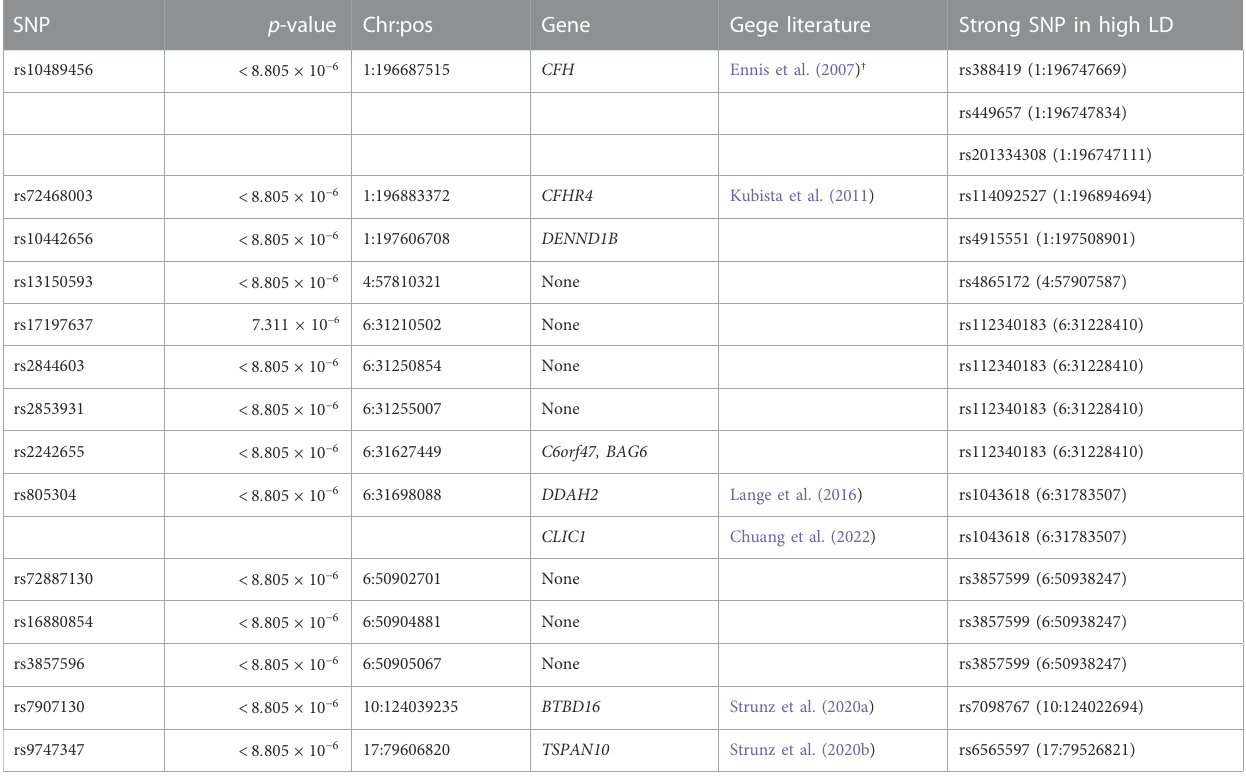
TABLE 2 Permutation p -values of selected marginally weak SNPs and their mapped genes. SNP p -value Chr:pos